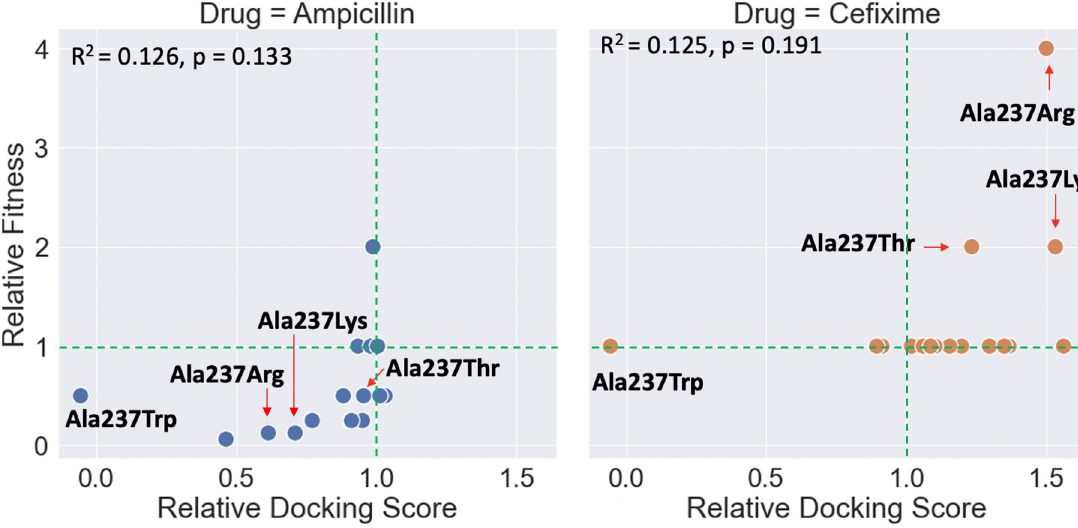
Fig 4. Comparison between changes in fitness upon treatment with either ampicillin (left) or cefixime (right) for E . coli carrying mutations in TEM’s codon 237 and the relative docking scores of each compound bound to each mutant structure. Results are tabulated in S4